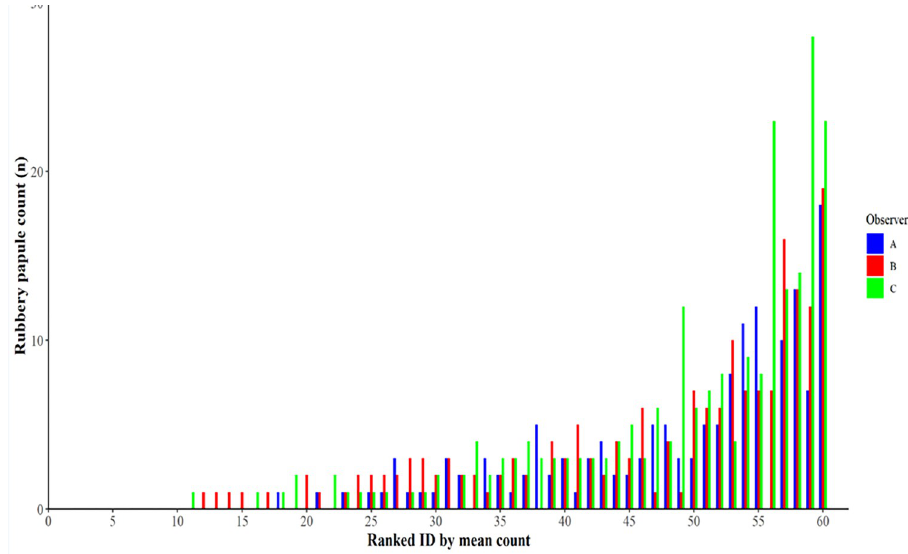
Fig 6. A box-and-whisker plot of median rubbery papule counts (n) and interquartile range for each observer (A, B, and C) rating the 60 digital images.